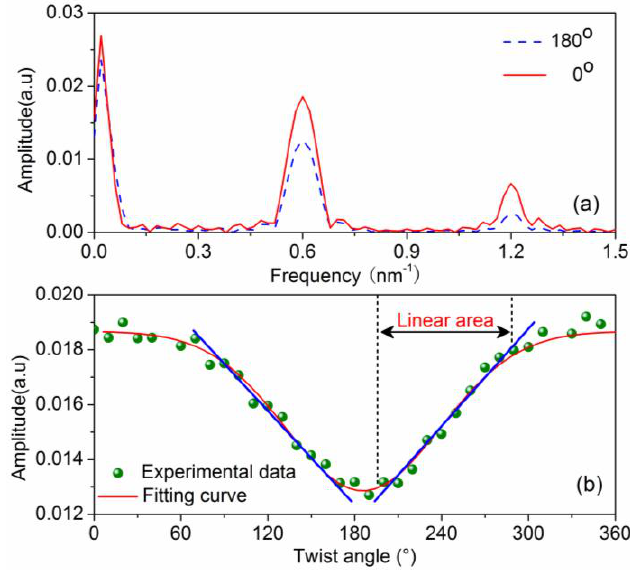
Figure 4. ( a ) Fast-Fourier transform (FFT) of the spectra; ( b ) Torsion responses of the Lyot-Sagnac interferometer.